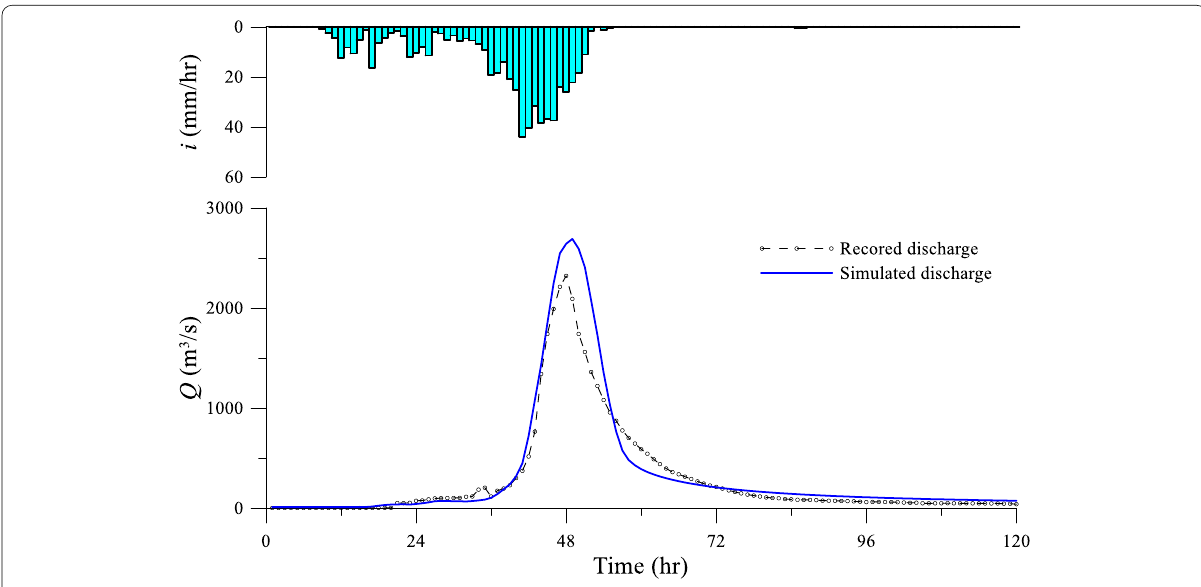
Fig. 4 Hydrograph simulation of the Shang‑Gui‑Shan Bridge watershed in 1996/07/30